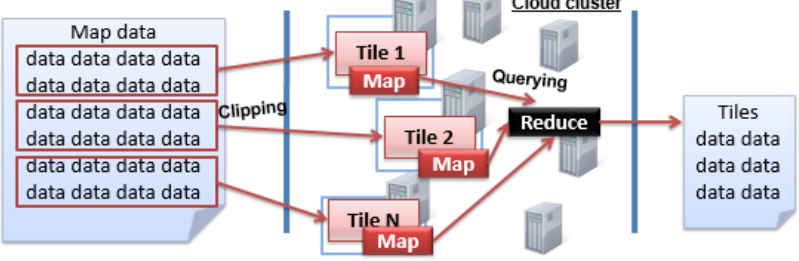
Figure 1. MapReduce framework based map tile data management.